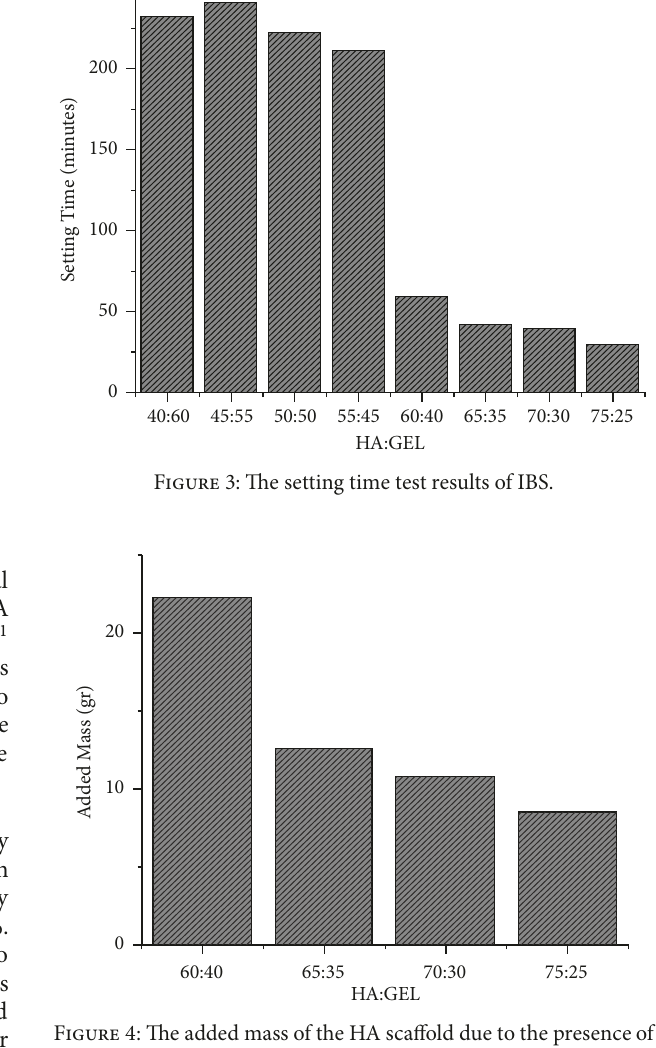
Figure 4: The added mass of the HA scaffold due to the presence of the